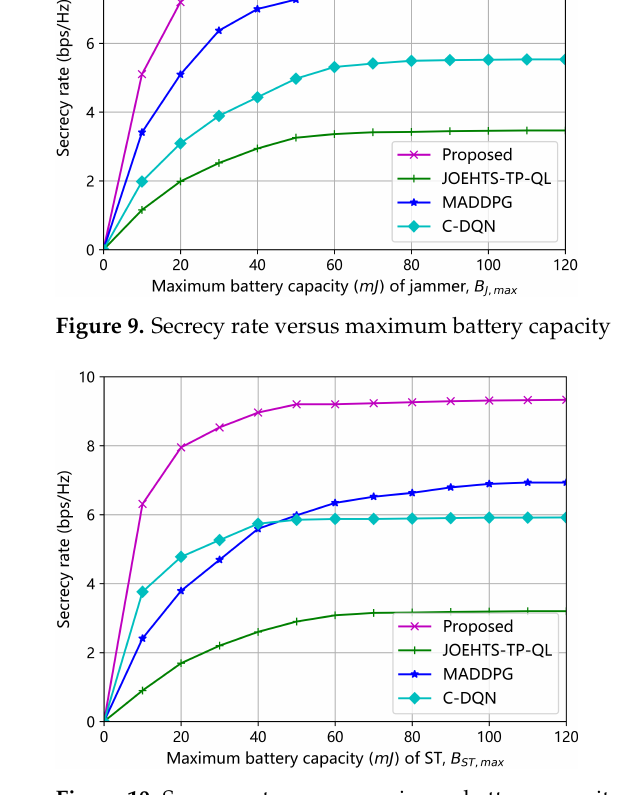
Figure 10. Secrecy rate versus maximum battery capacity B ST,max of ST.